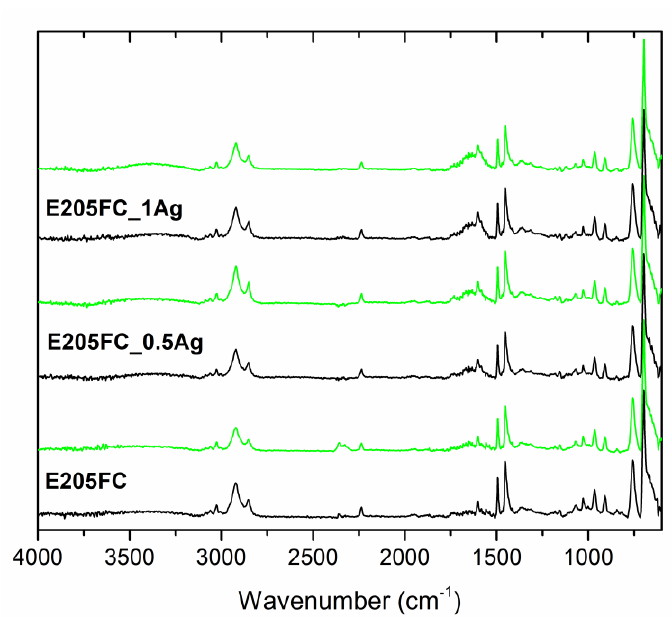
Figure 12. Attenuated total reflectance–Fourier transform infrared (ATR-FTIR) spectra of pure polymer (E205FC) and polymer containing 0.5 wt % and 1.0 wt % of silver nanoparticles AgNPs before incubation (black line) and after 24 months of incubation (light green line).